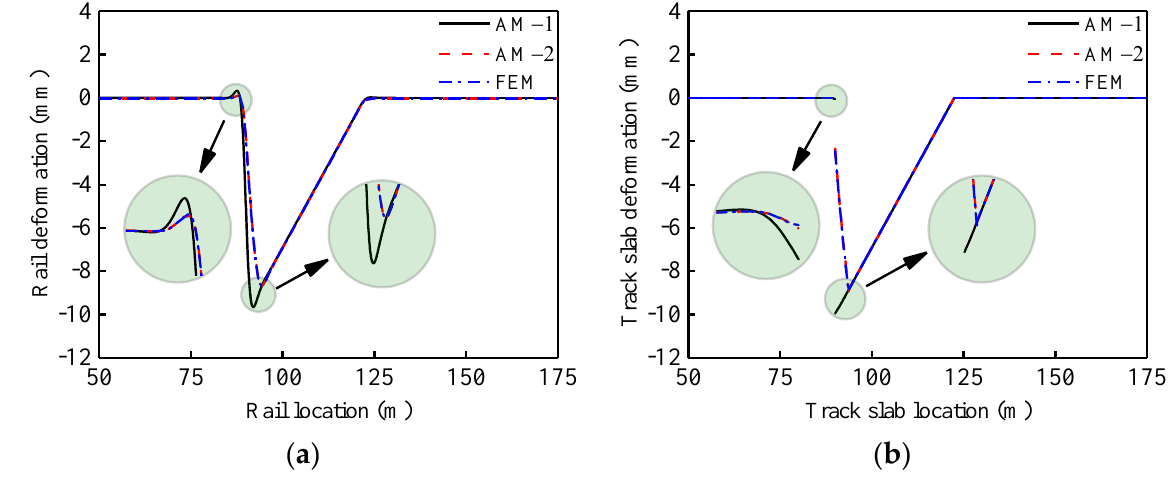
Figure 5. Case 2 ( a ) rail deformation; ( b ) track slab deformation.